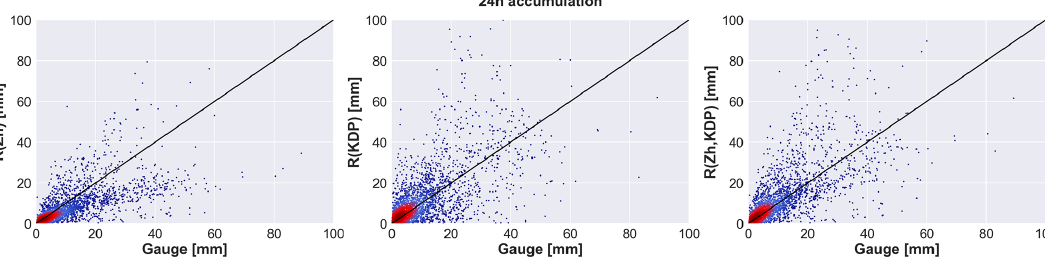
Figure 8. The 24h accumulations for Italy, 2012–2016. The corresponding verification measures are presented in Table 6. The number of radar–gauge data pairs with 42 gauges and accumulations > 0 . 1mm is 3010. Z H is not corrected for